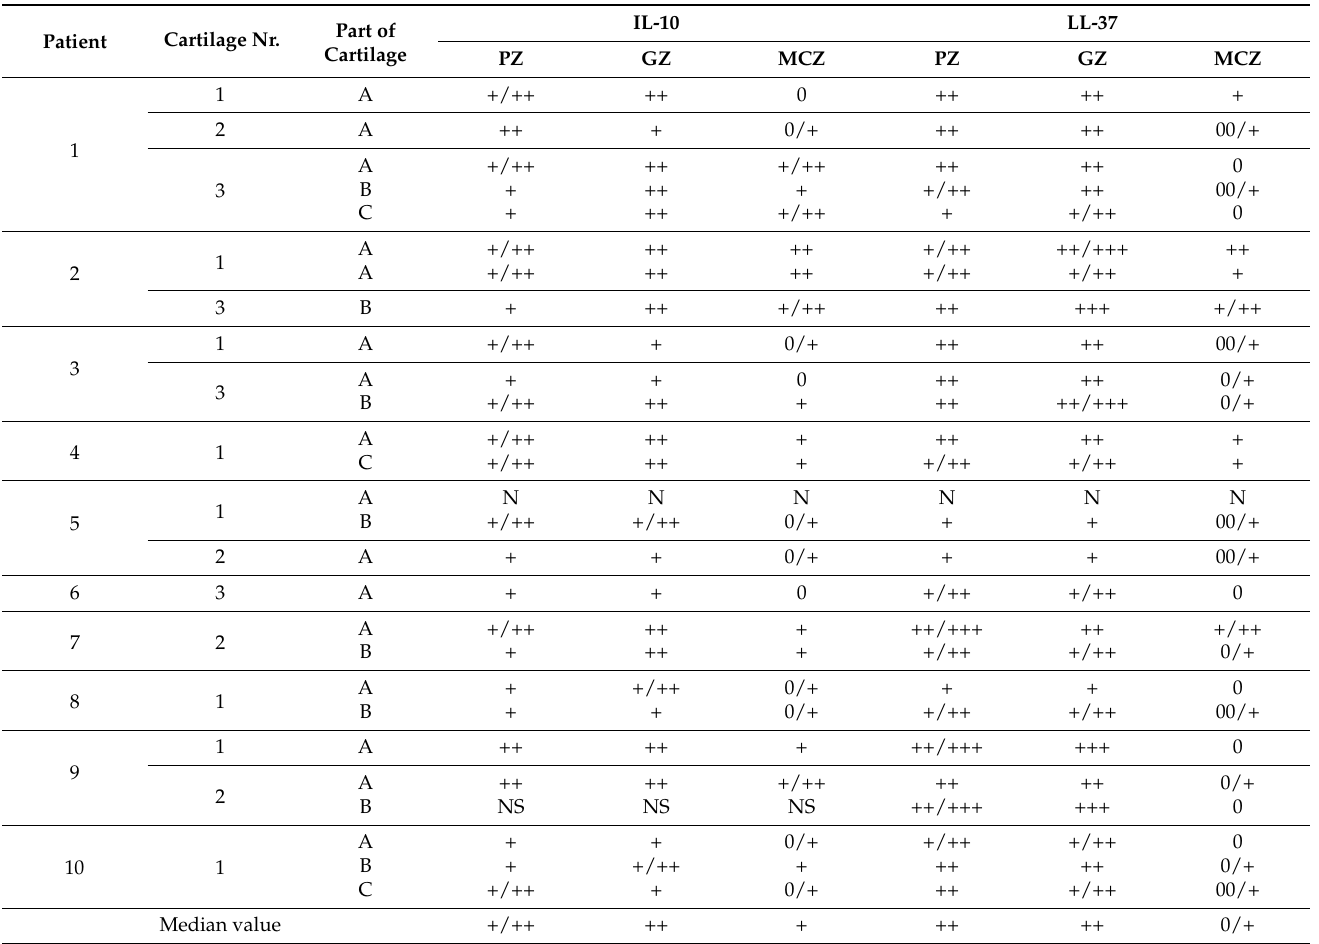
Table 4. Relative number of interleukin 10 and human cathelicidin positive cells in different tracheal hyaline cartilage zones.